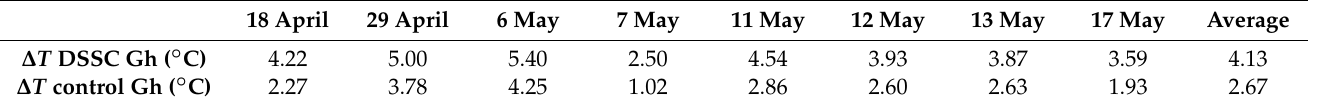
Figure A1. The morphological reactions of Misai Kucing cultivated under un-shaded (control) and red DSSC shaded greenhouses 10 weeks after planting. Table A2. ∆ T (the difference value between outside and inside) for both greenhouses: DSSC and control greenhouse.